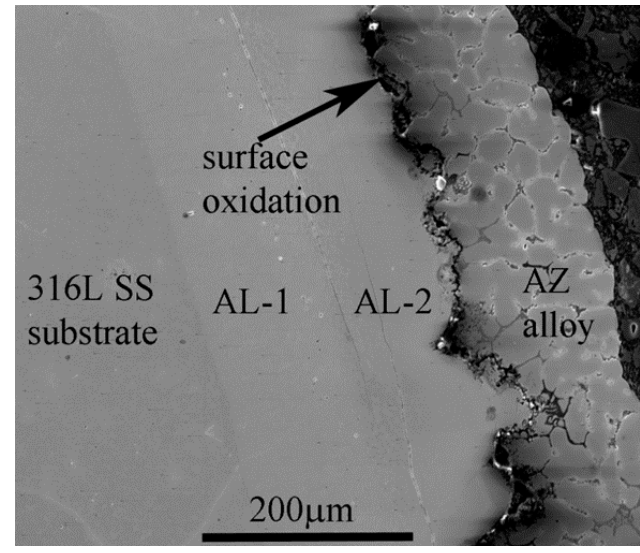
Figure 7. SEM-SEI image of SS sample after 7 days of immersion in the AZ alloy.